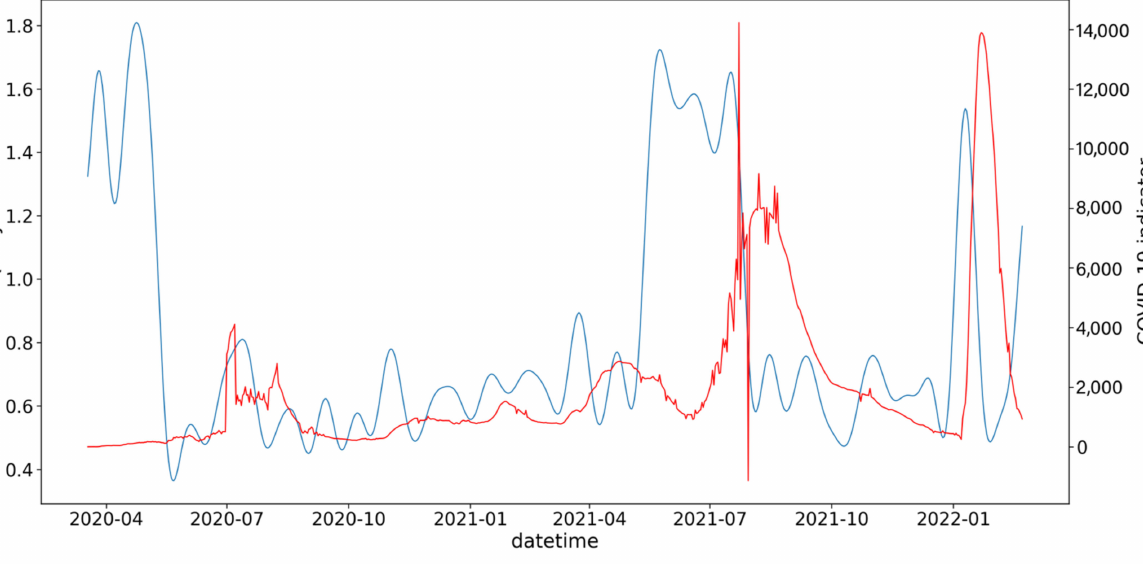
Figure A14. COVID-19 indicator—New cases. Query—Fake false information